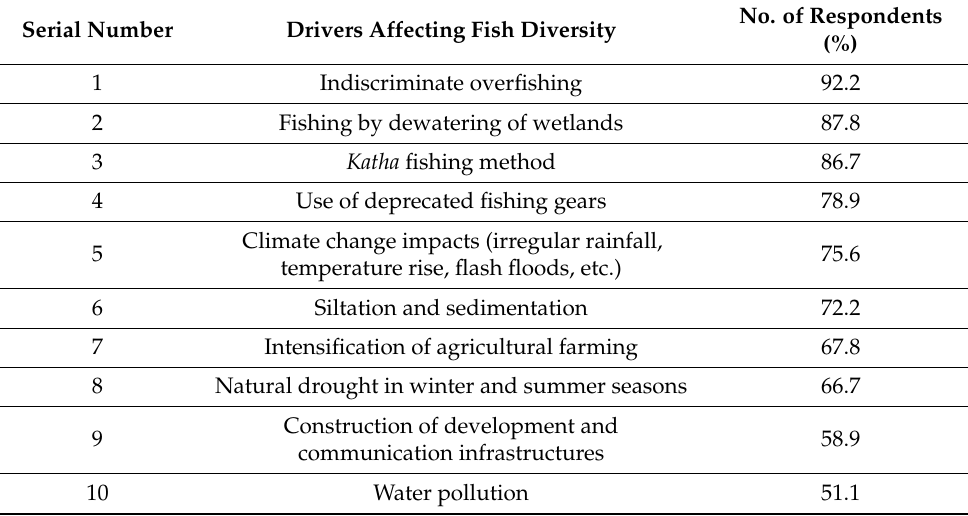
Table 3. Major threats to the fish biodiversity in the study